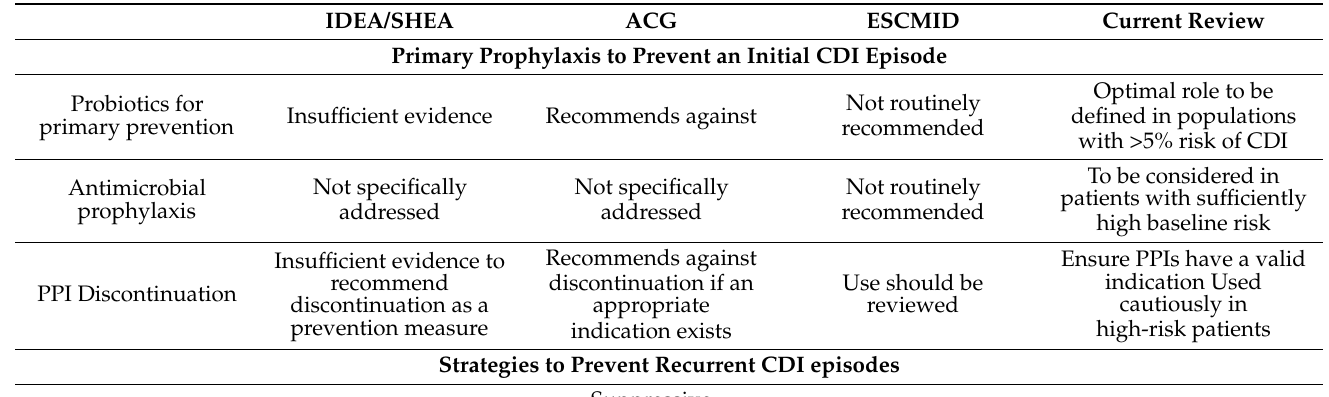
Table 2. Preventative Strategies in